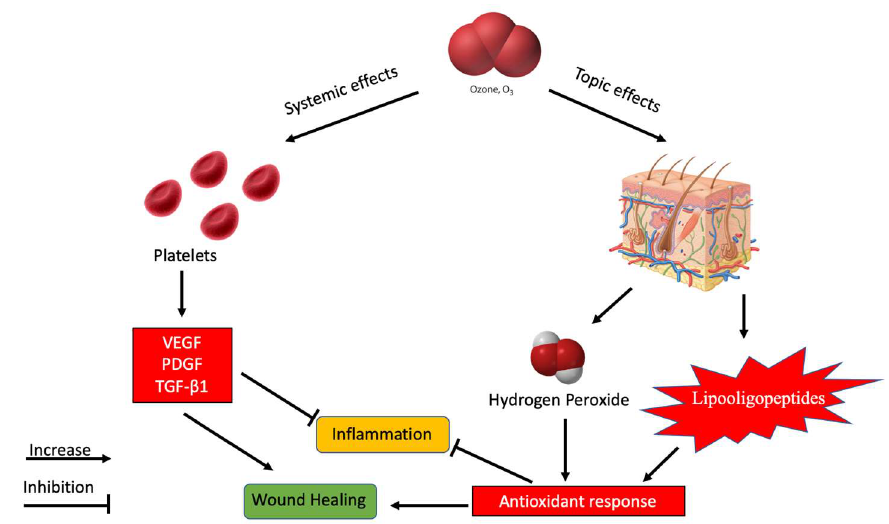
Figure 5. A schematic representation of the possible mechanisms of action of ozone on skin diseases.